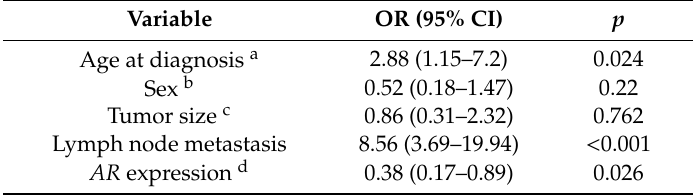
Table 3. Multiple logistic regression analysis of factors associated with extrathyroidal extension.